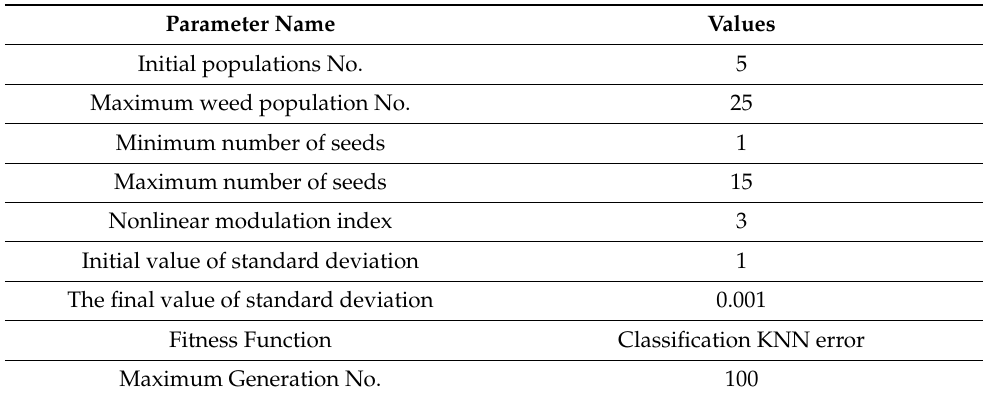
Table 4. The invasive weed optimization parameter settings for feature selection